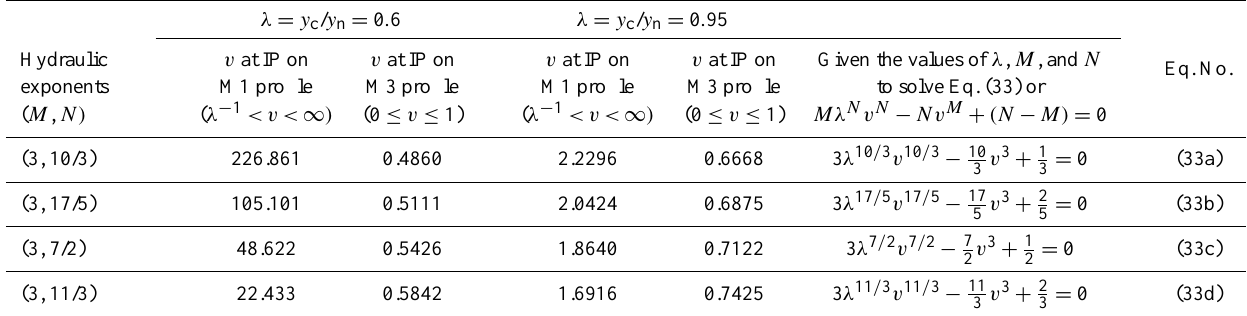
Table 2. The y c -based dimensionless flow depths at the two inflection points (IPs), one on the M1 profile and the other on the M3 profile, computed from Eq. (33) for the four N values of GVF profiles on two mild slopes ( y c / y n = 0 . 6 and 0.95) in wide channels ( M = 3). λ = y c / y n = 0 . 6 λ = y c / y n = 0 . 95